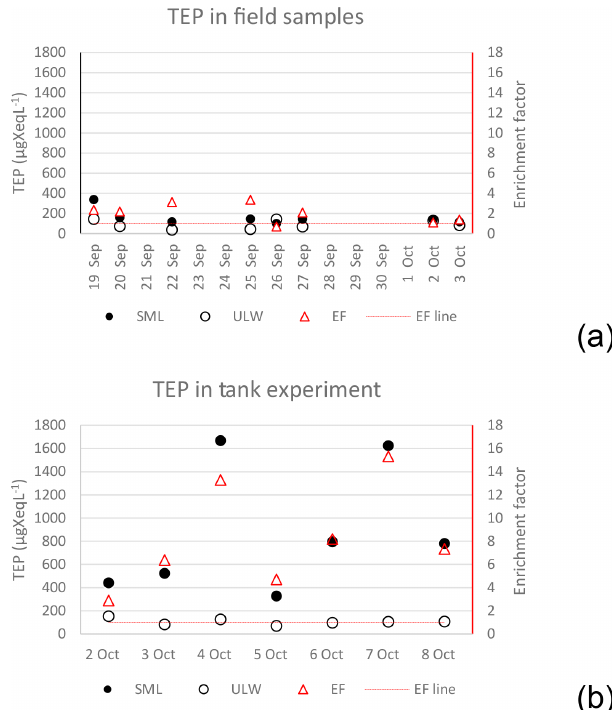
Figure 19. (a) Total TEP abundance in the SML and the bulk wa- ter as well as the enrichment factor (SML / ULW) of TEPs for field samples taken in the nearshore water of Cape Verde, (b) together with a tank experiment including > 3h bubbling of water collected from nearshore Cape Verde.